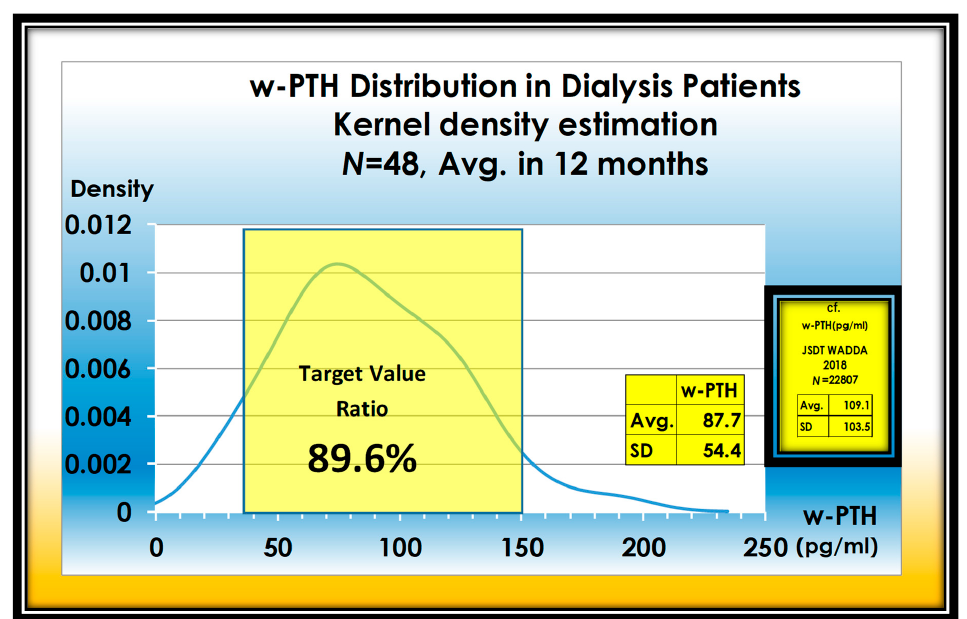
Figure 5. Changes in w-PTH levels in 48 dialysis patients. Average of w-PTH is 87.7 pg/mL. SD is 54.4 pg/mL. Maximum of w-PTH is 387 pg/mL. w-PTH—whole-PTH.